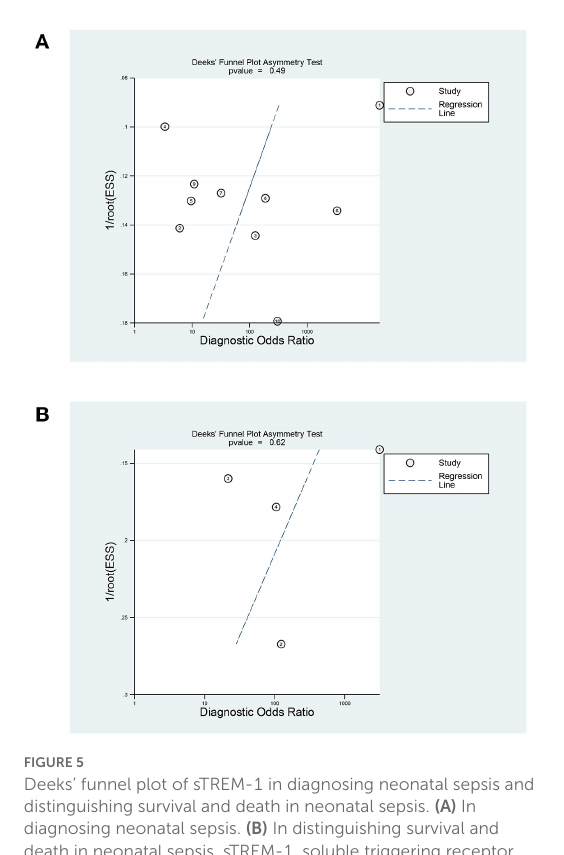
FIGURE5 Deeks’ funnel plot of sTREM-1 in diagnosing neonatal sepsis and distinguishing survival and death in neonatal sepsis. (A) In diagnosing neonatal sepsis. (B) In distinguishing survival and death in neonatal sepsis. sTREM-1, soluble triggering receptor expressed on myeloid